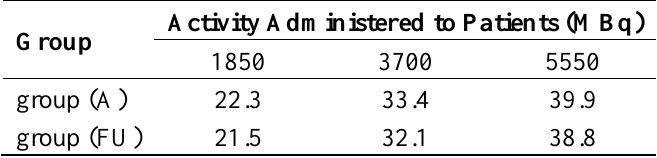
Table 1. Release time for patients (h).